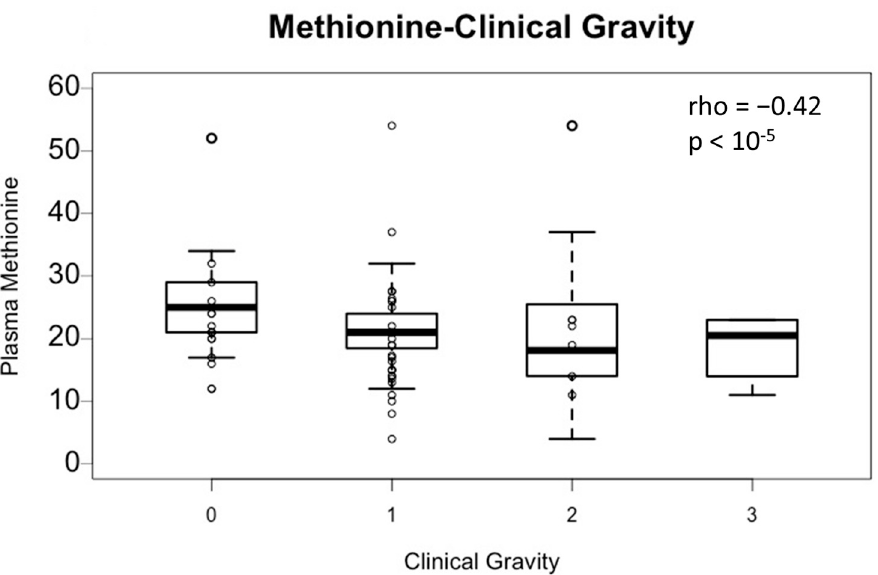
Figure 1. Plasma Methionine according to the clinical severity of N2O consumption. Groups are based on the severity of their clinical symptoms (based on Peripheral Neuropathy Disability (PND) score: level 0: no symptoms; level 1: paresthesia or PND I; level 2: gait disorders or PND II; level 3: thrombosis or combined subacute degeneration of spinal cord or PND III or IV. p -value and rho were obtained by non-parametric Spearman rank test. Data are expressed as median ± IQR.